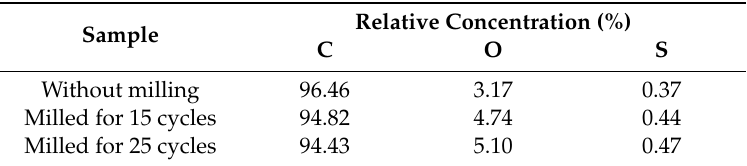
Table 2. Variation of the elemental concentrations on the GTR surface during pan milling (reproduced with permission from